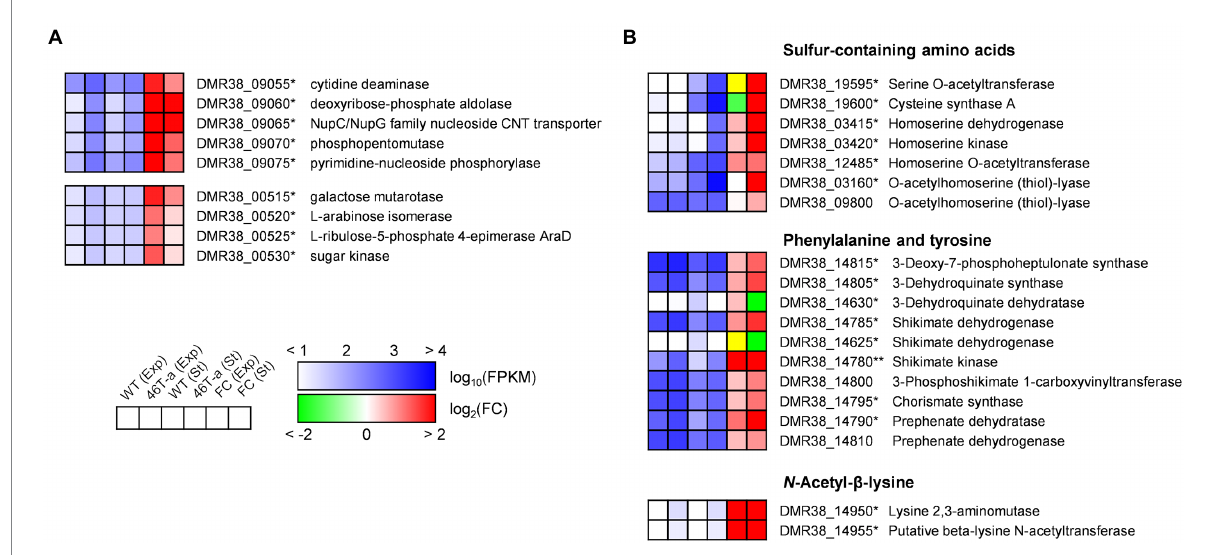
FIGURE 6 Transcription profiles of selected genes involved in carbohydrate utilization (A) and amino acid biosynthesis (B) . The colorimetric scale is the same as in Figure 5. The yellow color in the fold change box indicates that the fold change value might not be valid because both FPKM values were too low (<10). Single and double asterisks next to the locus tag indicate differential expression with statistical significance (|log 2 (folds)| > 1 and FDR < 0.001) in one and two phases,